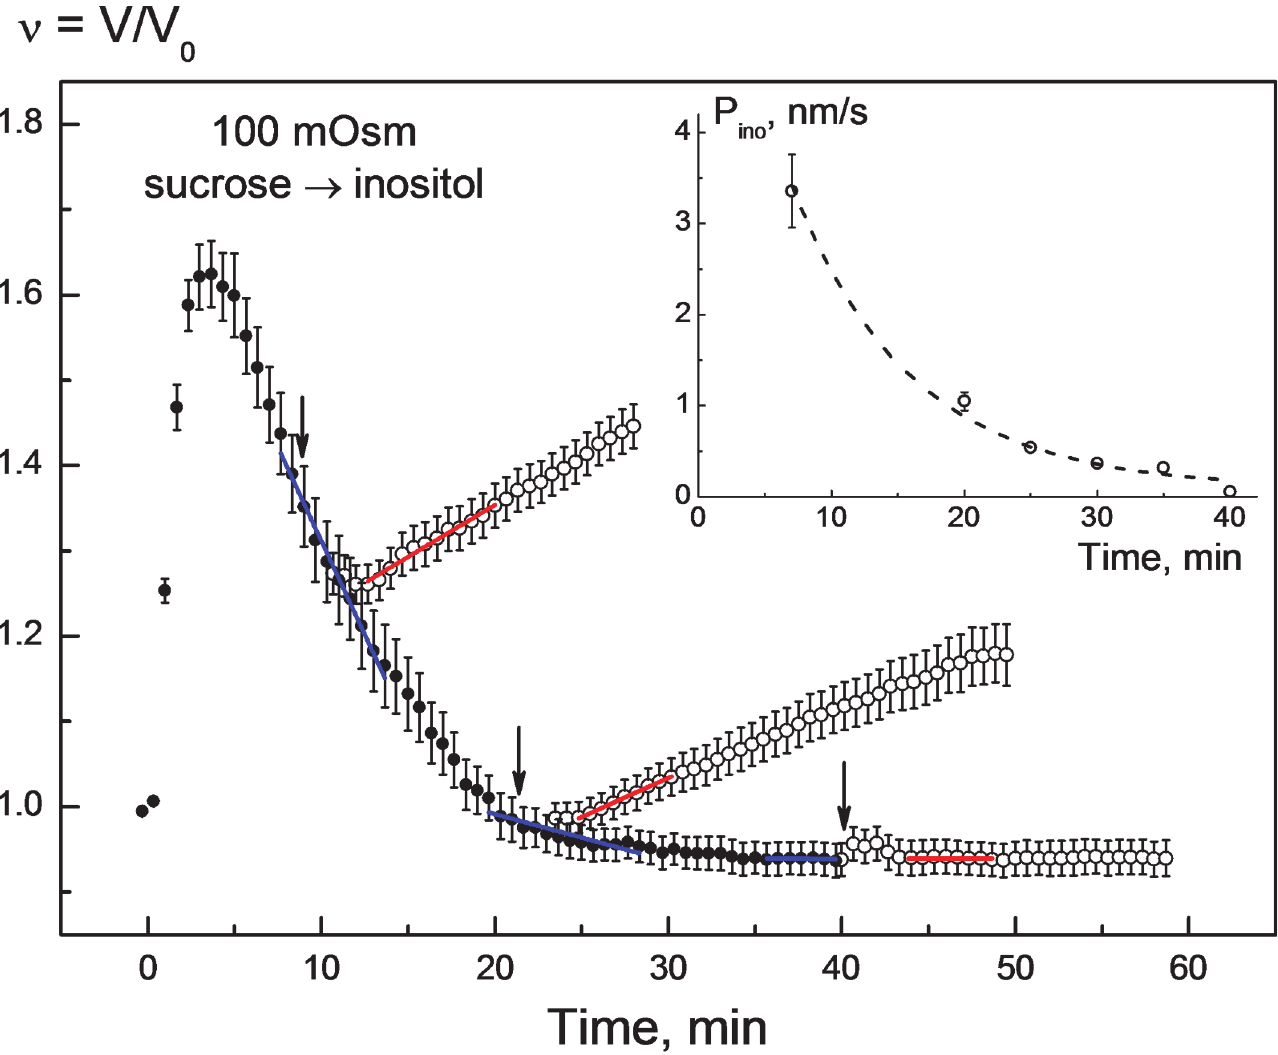
Fig 1. Changes in the normalized volume v = V/V 0 of HEK293 cells in response to sequential application of sucrose and myo -inositol solutions of the same osmolality of 100 mOsm. The cells were bathed initially ( time < * 30 s) in isotonic growth medium (300 mOsm) and then exposed to a 100- mOsm sucrose solution. The strongly hypotonic sucrose solution ( filled symbols ) caused fast cell swelling to a transient maximum volume v max of * 1.6 within the first 2 – 3 min. After the initial swelling, the cells underwent RVD, i.e. they gradually shrank to reach the original isotonic volume ( v 0 (cid:4) 1) within * 20 min in the presence of sucrose. The replacement of sucrose by an equiosmotic amount of myo -inositol ( arrows ) abolished RVD and caused secondary cell swelling ( empty symbols ). The rate of secondary swelling ( Δ v / Δ t ino , red fitted lines ) decreased with time during and after RVD (7 – 35 min). The addition of myo -inositol 40 min after hypotonic shock did not cause any significant cell swelling. Each data point represents the mean ± SE of 25 – 42 individual cells measured in 2 – 3 independent experiments. For each time point of myo -inositol addition, the rates of RVD Δ v / Δ t RVD ( blue lines ) and the rates of secondary swelling Δ v / Δ t ino ( red lines ) were determined to calculate the permeability coefficients for myo-inositol P ino by applying Eqs. 1 and 2. The inset illustrates the decay of P ino with time during